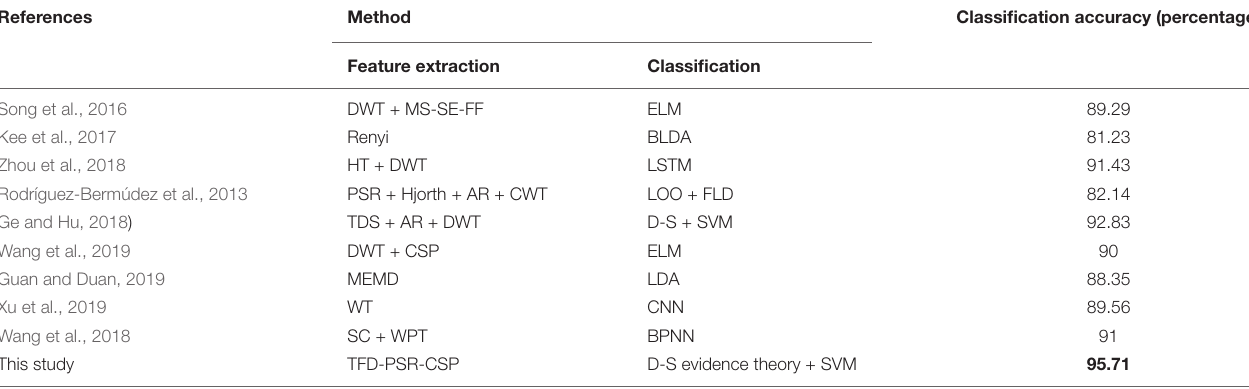
TABLE 5 | Comparison of classification accuracy between the methods proposed in this study and the existing methods in data set 1.